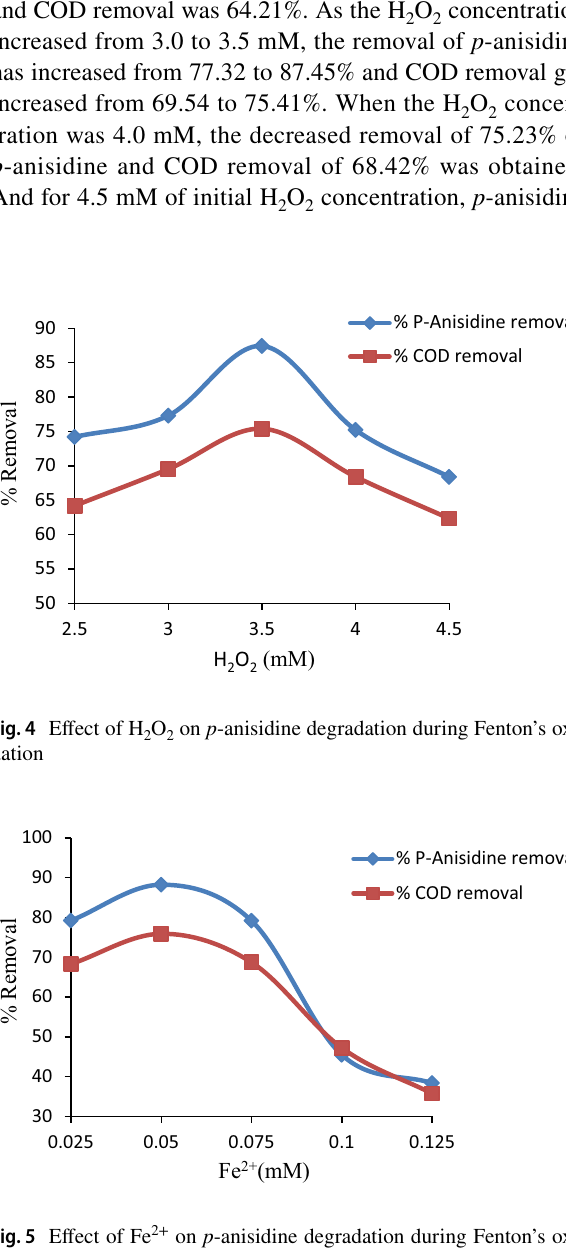
Fig. 5 Effect of Fe 2+ on p -anisidine degradation during Fenton’s oxi-